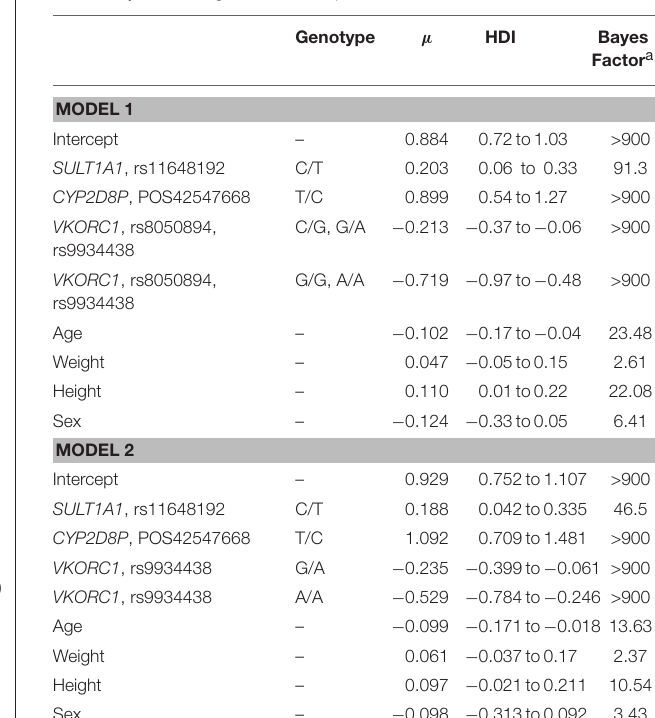
TABLE 4 | Pharmacogenomic model